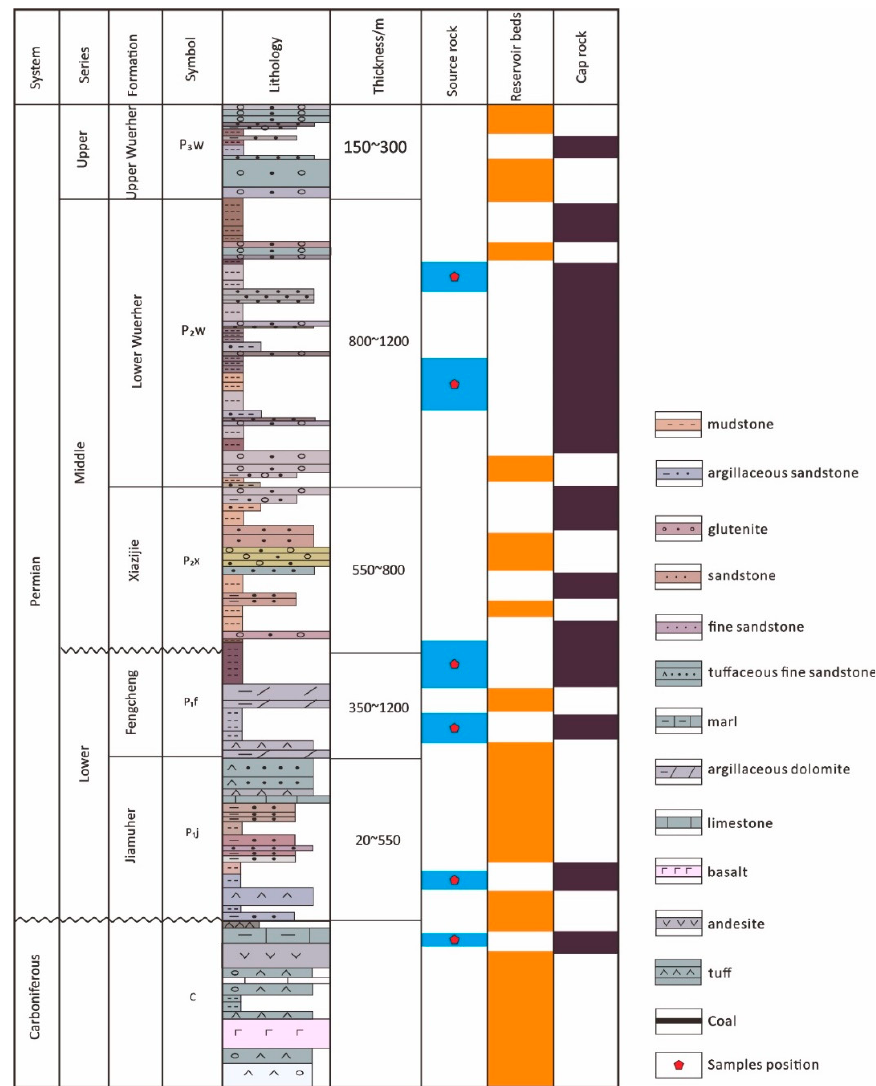
Figure 2. Lithological stratigraphy in the Junggar Basin (After reference [10]). Reprinted with permission from Ref. [10]. 2020, Elsevier.